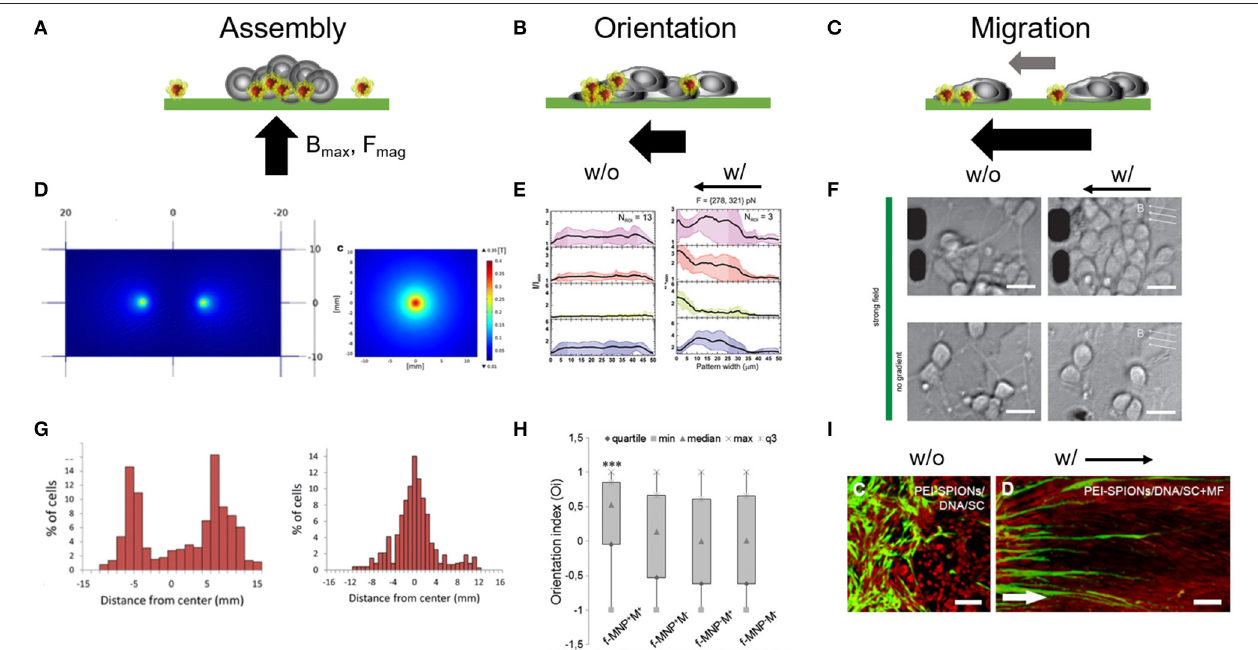
FIGURE 3 | Magnetic forces as cell patterning mediators. Tuning magnetic force amplitudes (F mag ), the position of the maximal magnetic field (B max ) and the orientation of the magnetic field pole indicated through the black arrow provides a versatile approach for cell assembly. (A–C) Schematic represents different magnetic field gradient orientations and magnitudes and its impact on cell assembly and organization. (D) Single vs. two pole magnetic field gradient spots for positioning of cells. Reproduced with permission from Marcus et al. (2016), Copyright © 2016, BioMed Central. (E) Fluorescence distribution plots taken from primary cortical neuron cultures show a shift of intracellular markers toward left oriented magnetic gradient forces. w/o, no magnetic field; w/, with magnetic field. Reproduced with permission from Kunze et al. (2015). (F) Primary cortical neurons dissociated from rat brain tissues (E18) were cultured on poly-l-lysine surfaces and exposed to fMNPs after being 24h in culture. These neurons grow and form neurite networks under magnetic fields and start migration toward magnetic field poles under strong magnetic forces ( > 250 pN). Scale bar = 12 µ m. Reproduced with permission from Kunze et al. (2015), Copyright © 2015, American Chemical Society. (G) Histogram plots of accumulated neuron-like cells which were cultured above the single and two pole patterns, respectively. (H) Orientation index extracted from PC12 that were observed to align in parallel to magnetic field orientation after being cultured with fMNPs. f-MNP-M + , fMNPs with magnetic field; f-MNP-M − , fMNPs without magnetic field. Reproduced with permission from Riggio et al. (2014), Copyright © 2014, Elsevier Inc. (I) Schwann cells migrate into astrocyte-rich region under an oriented magnetic field gradient after internalizing PEI-fMNPs (PEI-SPIONs). White arrow indicates direction of magnetic pole. Scale bar = 100 µ m. Reproduced with permission from Xia et al. (2016), Copyright © 2016, Dove Medical Press